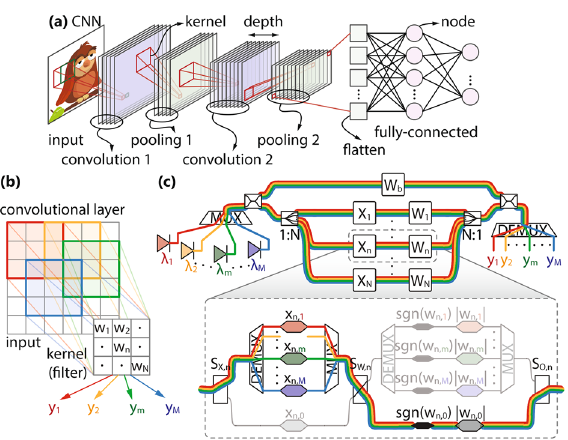
Figure 2. ( a ) Simplified CNN inspired by LeNet-5, employed in image classification. ( b ) Schematic of a convolutional layer with color coded input/output pairs and ( c ) its implementation over PPNN in mode #2 where each channel m corresponds to one input/output